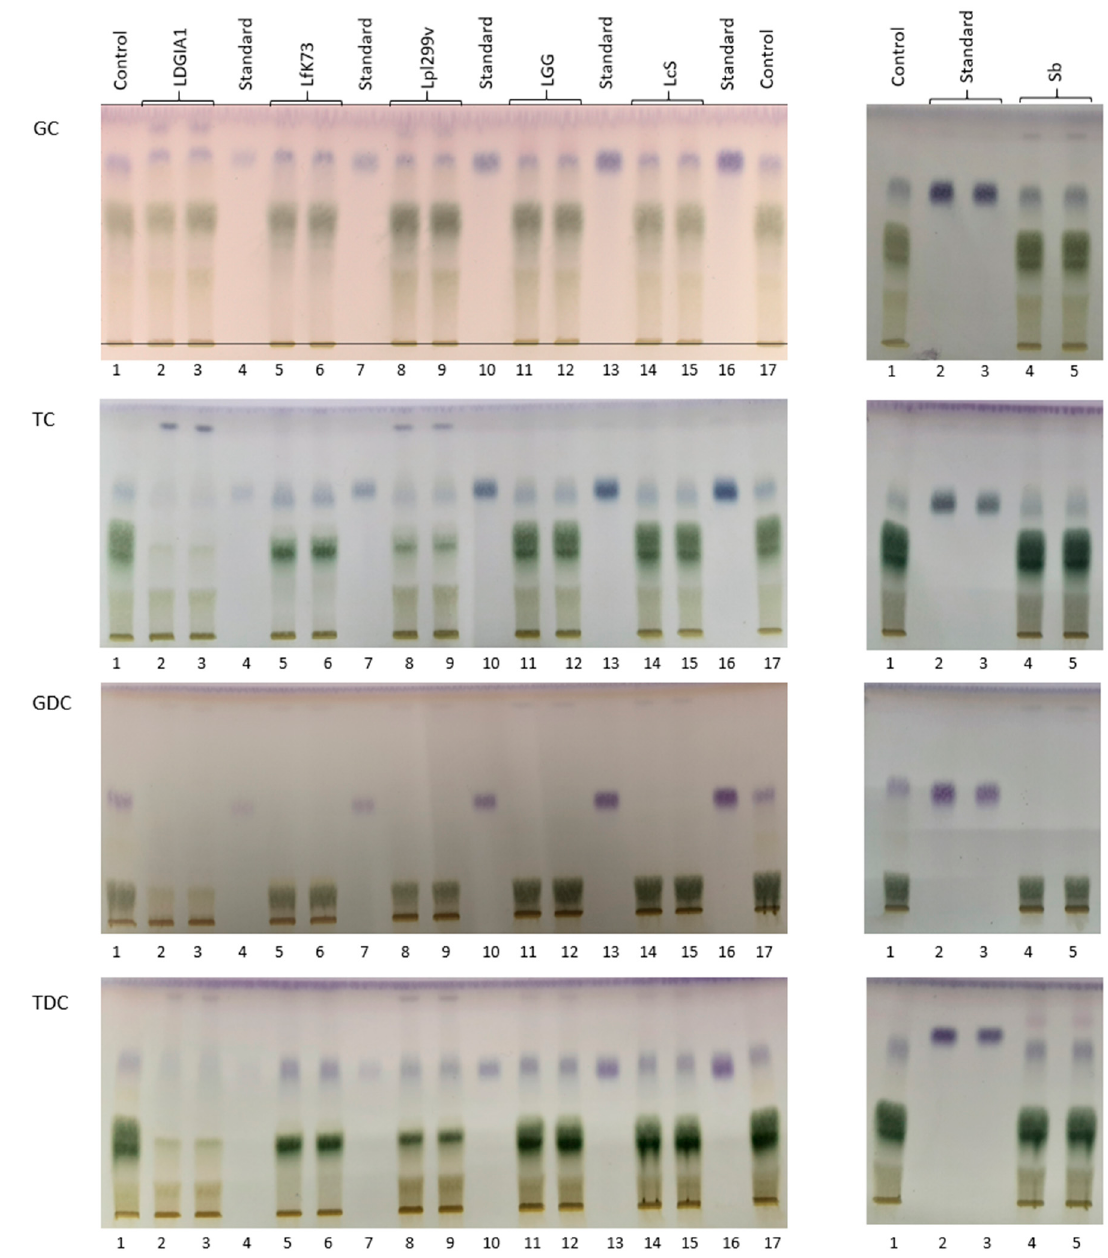
Figure 2. Quantitative assay of deconjugated bile acids in the cell-free supernatant from the six probiotic strains cultured at 37 °C for 24 h in MRS broth (YPD broth for SB) separated on HPTLC plates and derivatized with p-anisaldehyde/sulfuric acid. GC, sodium glycocholate; TC, sodium taurocholate; GDC, sodium glycodeoxycholate; TDC, sodium taurodeoxycholate; LDGIA1, Lactobacillus plantarum DGIA1; LfK73, Lactobacillus fermentum K73; Lpl299v, Lactobacillus plantarum 299v; LGG, Lactobacillus rhamnosus GG; LcS, Lactobacillus casei Shirota; SB, Saccharomyces boulardii .